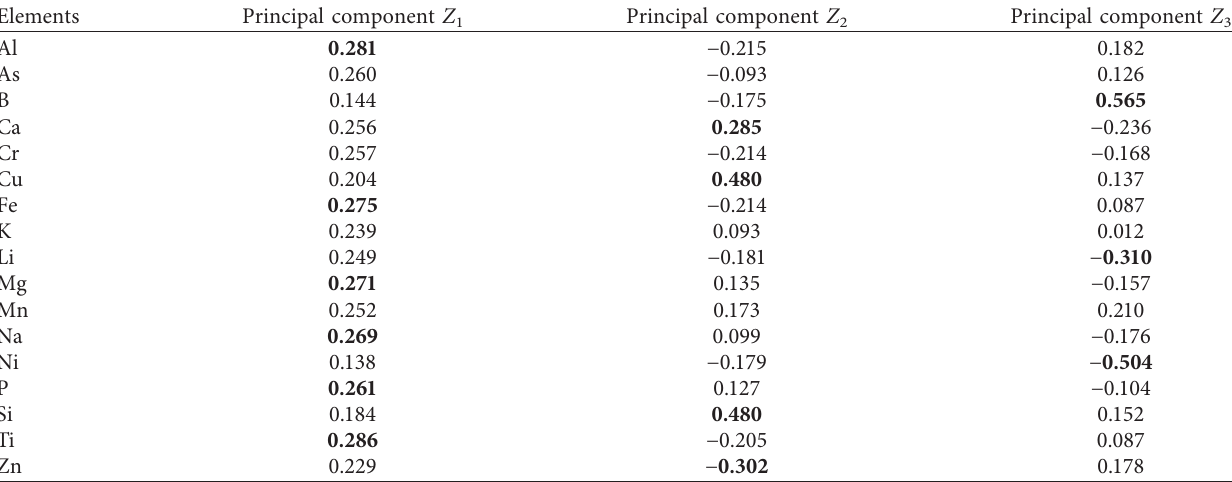
Table 8: Principal component